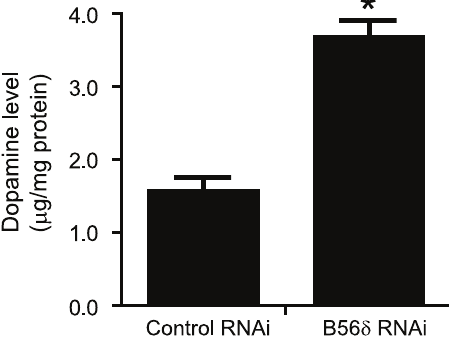
Figure 6. Dopamine synthesis in N27 cells is increased following down-regulation of B56 d . N27 cells were infected with AAV-control RNAi or AAV- B56 d RNAi for 72 h. Dopamine was measured in cell lysates by LC/MS with tritium labeled DA as a standard. Data are shown as means 6 s.e.m. (n=3). *, P , 0.01 compared with control RNAi infected cells by student’s t-test.